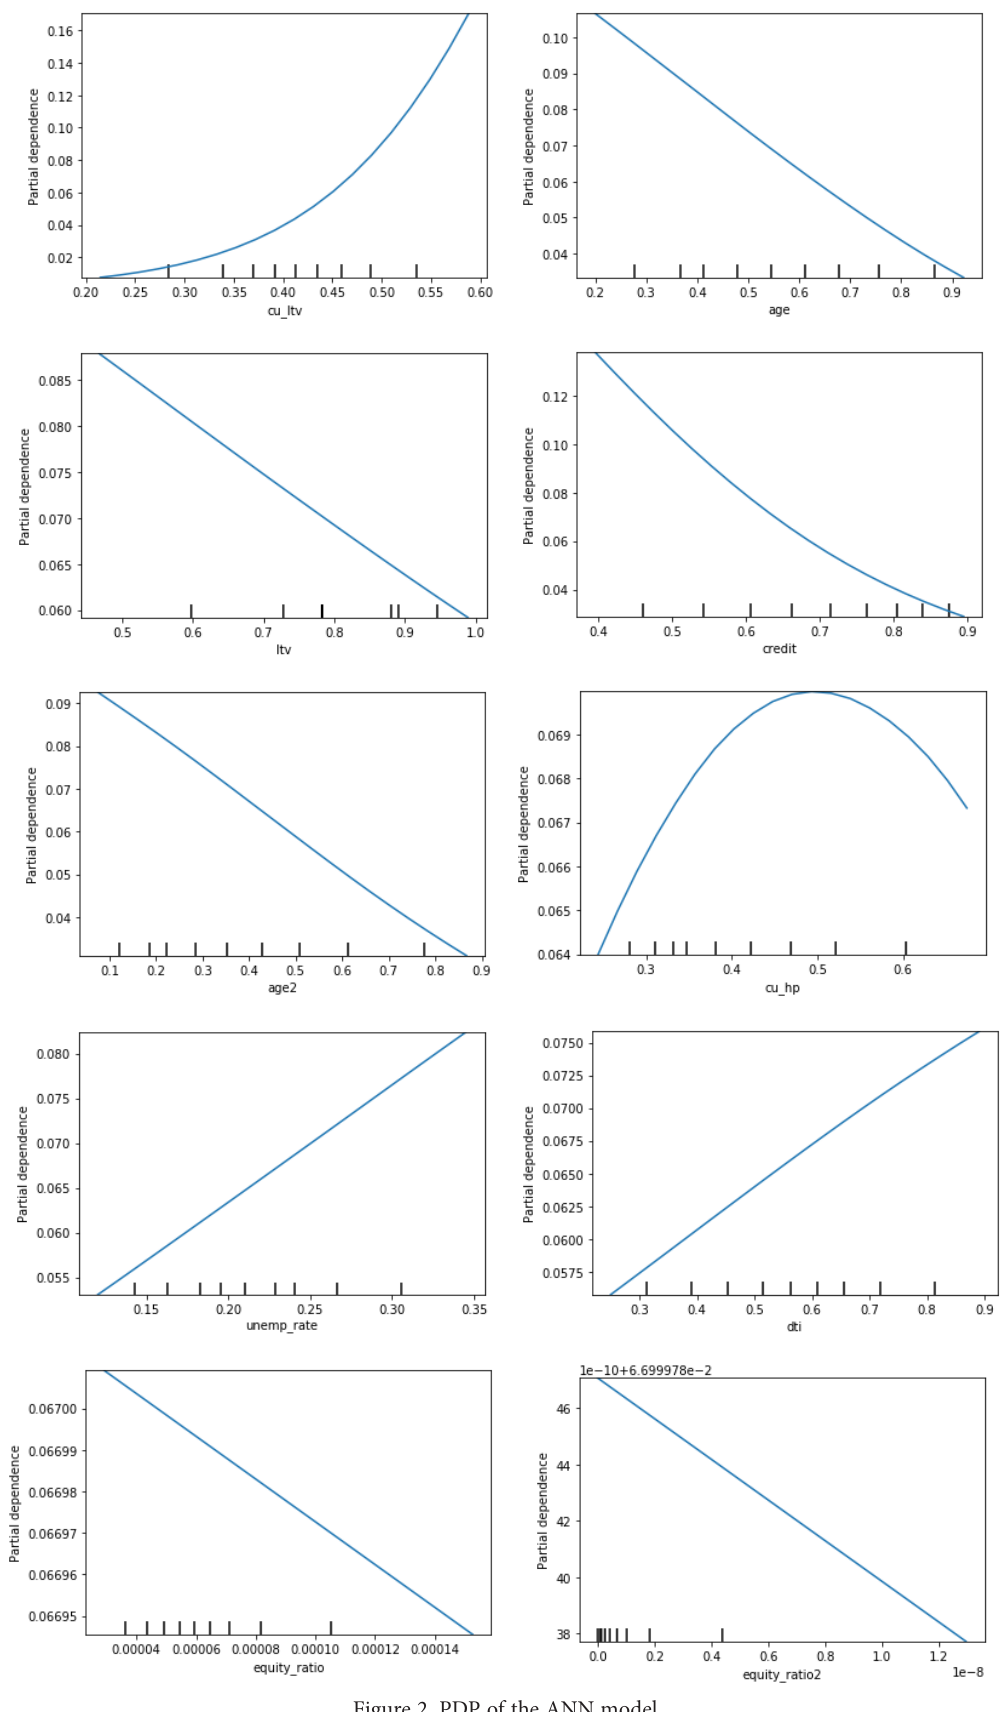
Figure 2. PDP of the ANN